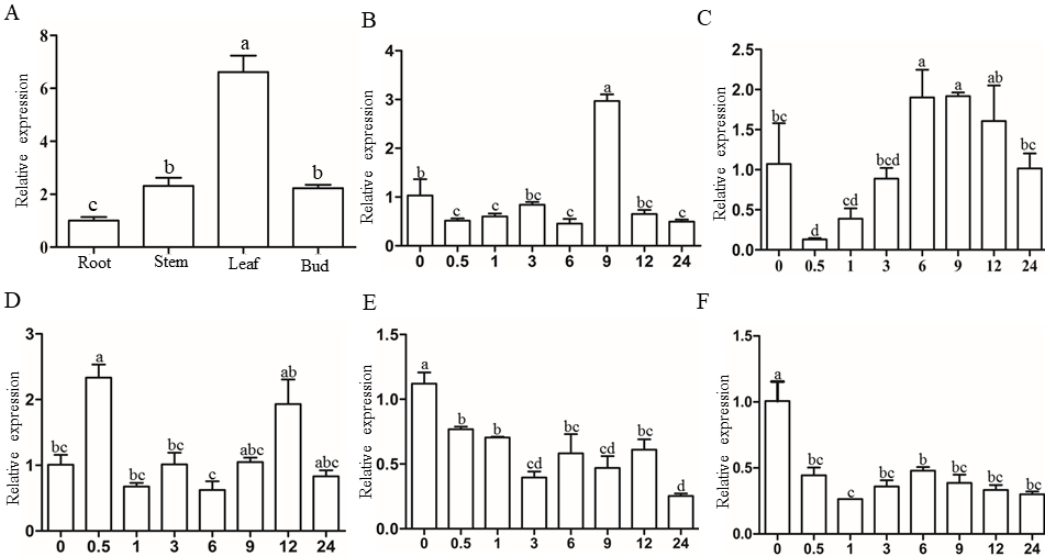
Figure 1. Expression profiling of SbSGT1 . ( A ) Tissue specificity of SbSGT1 in sorghum root, stem, leaf, and bud, respec- tively; ( B – F ) Analysis of SbSGT1 response to indole-3-acetic (IAA), salicylic acid (SA), abscisic acid (ABA), brassinosteroids (BR), and strigolactone (SL) stresses at 0–24 h, respectively. Internal reference gene: SbEIF4a ; Different lowercase letters indicate the significance of the difference between the treatment groups ( p < 0.05).